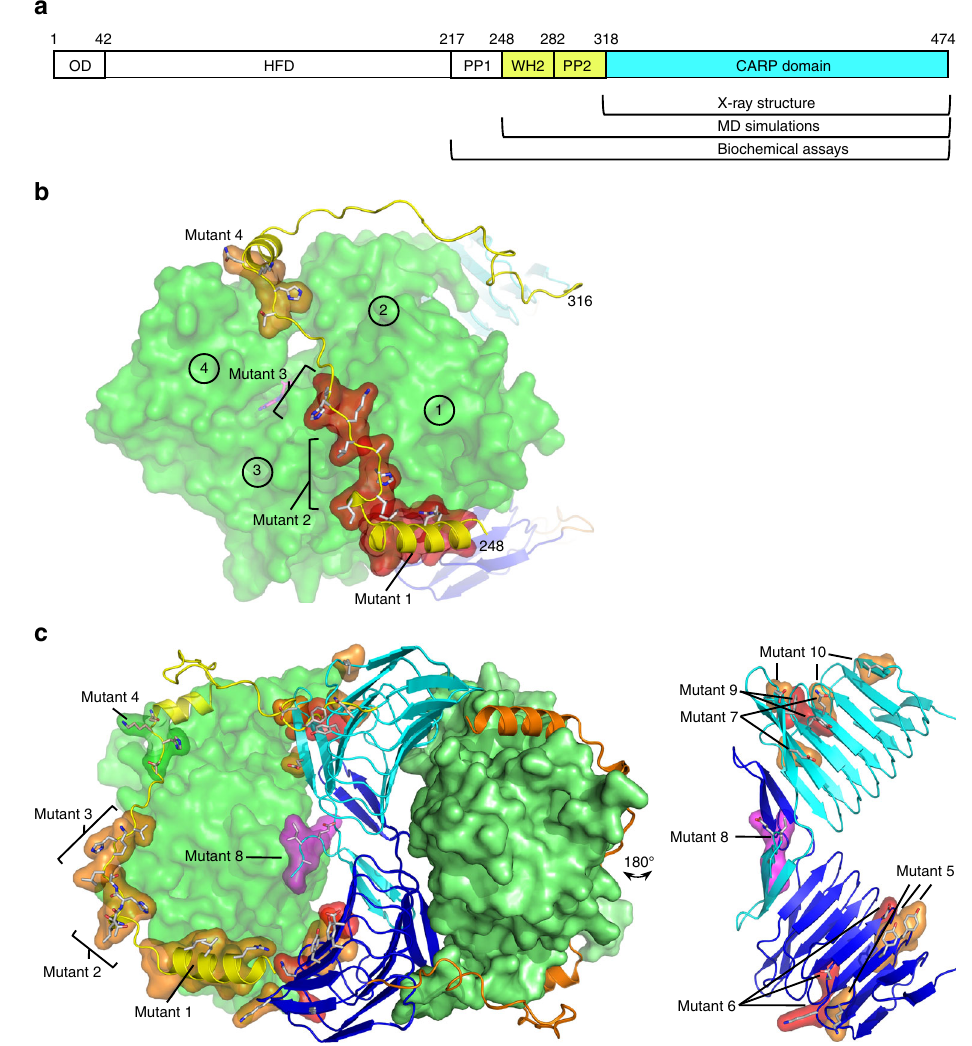
Fig. 3 Structural mechanisms of ADP-G-actin and ATP-G-actin interactions with CAP1. a The domain architecture of CAP1. Oligomerization domain (OD), helical folded domain (HFD), polyproline region 1 (PP1), WH2 domain, polyproline region 2 (PP2), and CARP domain. The CAP1 regions in co-crystal structure and atomistic MD simulations model are indicated in cyan and in yellow, respectively. b MD simulation model of the ATP-actin – WH2 domain complex (System 3, Supplementary Table 3). The regions important for ATP-actin binding as determined by mutagenesis are highlighted in orange and red. Actin subdomains 1 – 4 are indicated by circles. c The ADP-G-actin – CAP1 248 – 474 complex model (System 2, Supplementary Table 3) from MD simulations. The regions important for ADP-G-actin binding are indicated in orange and red, and the C-terminal tail of CAP1 is in magenta. For detailed effects of the mutants on actin binding, see Table 1 and Supplementary Fig. network in the nucleotide-binding loops P1 and P2 of actin. combining homology-modeled WH2 domain with the crystal These differences are relayed to methylated His 73 located in the “ sensing loop ” that changes conformation between the two nucleotide states of actin 51 . Our structure revealed that the C- between a backbone oxygen of CARP Ala 473 and the imidazole ring of actin His 73 (Fig. 4a, b). Moreover, two other possible sensing region of actin were revealed in MD simulations of the Table 3, Supplementary Fig. 6a), proposing that the C-terminal tail of CAP may contribute to nucleotide exchange on actin. Mechanism of CAP-catalyzed nucleotide exchange . One fasci- We generated mutant versions of mouse and budding yeast nating feature of the CARP domain — ADP-actin co-crystal C-CAPs lacking the four C-terminal residues ( Δ 4C). Importantly, structure is the close proximity of the C-terminal tail of the this same mutation in both proteins caused severe defects in nucleotide exchange on actin without compromising ADP-G- The occupancy of third phosphate alters the hydrogen bonding actin binding. Instead, the Δ 4C mutants bound ADP-G-actin